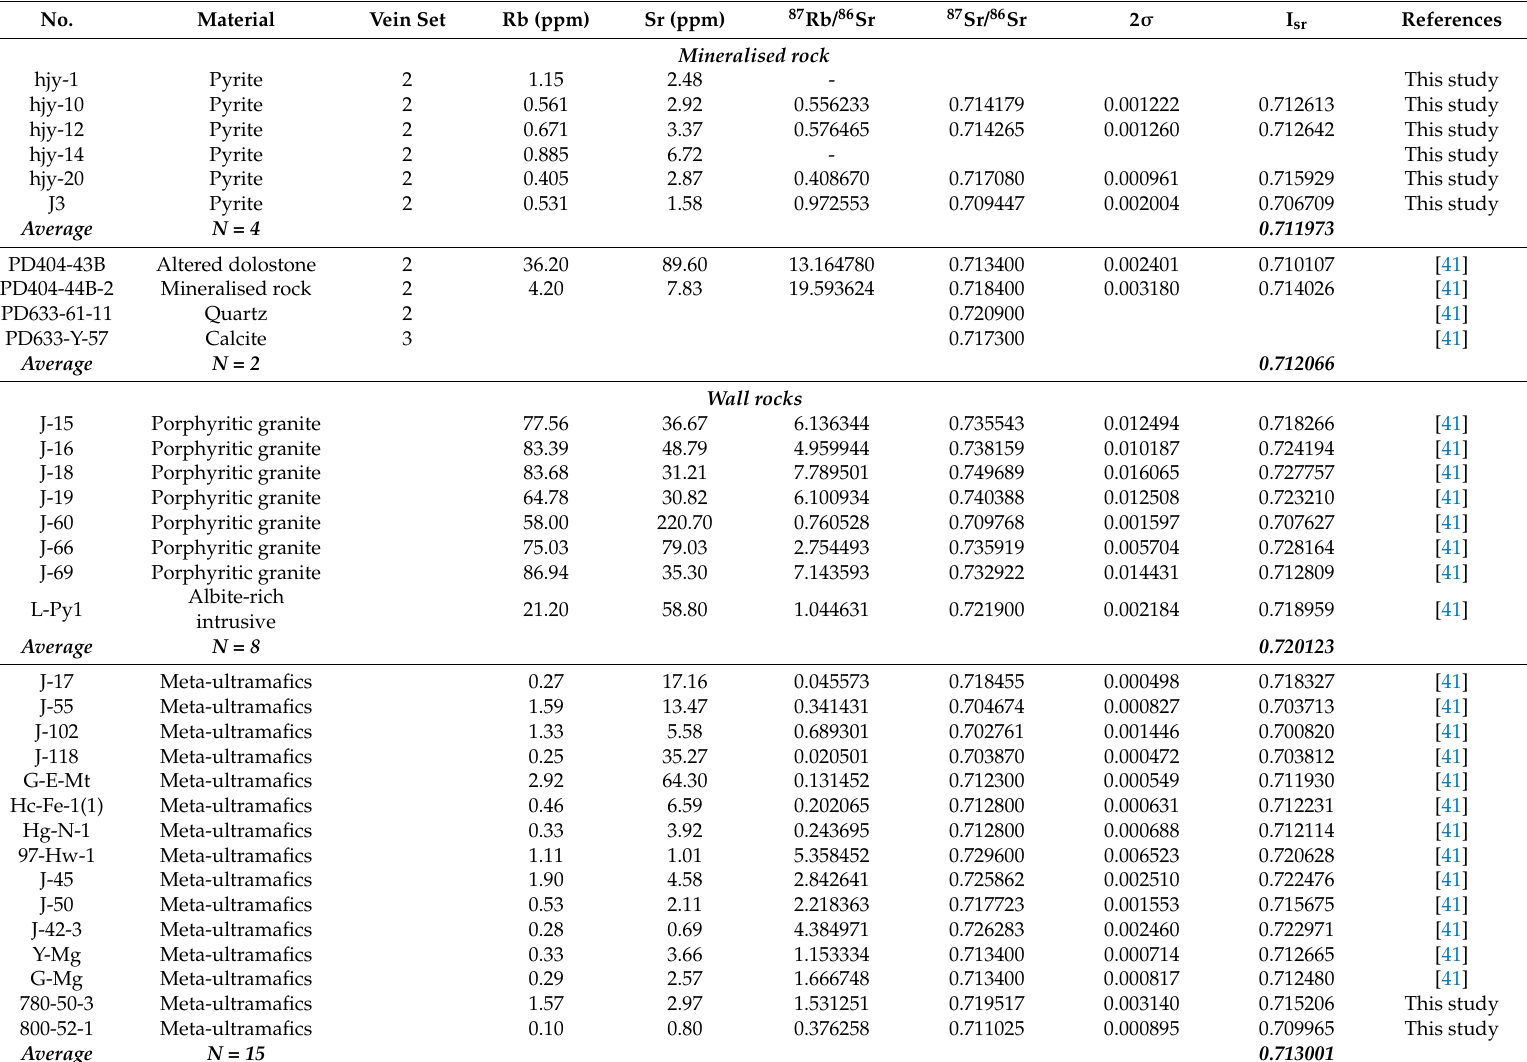
Table 5. The Sr isotope ratios of sulfides and wallrocks at the Jianchaling Au deposit and in the Bikou